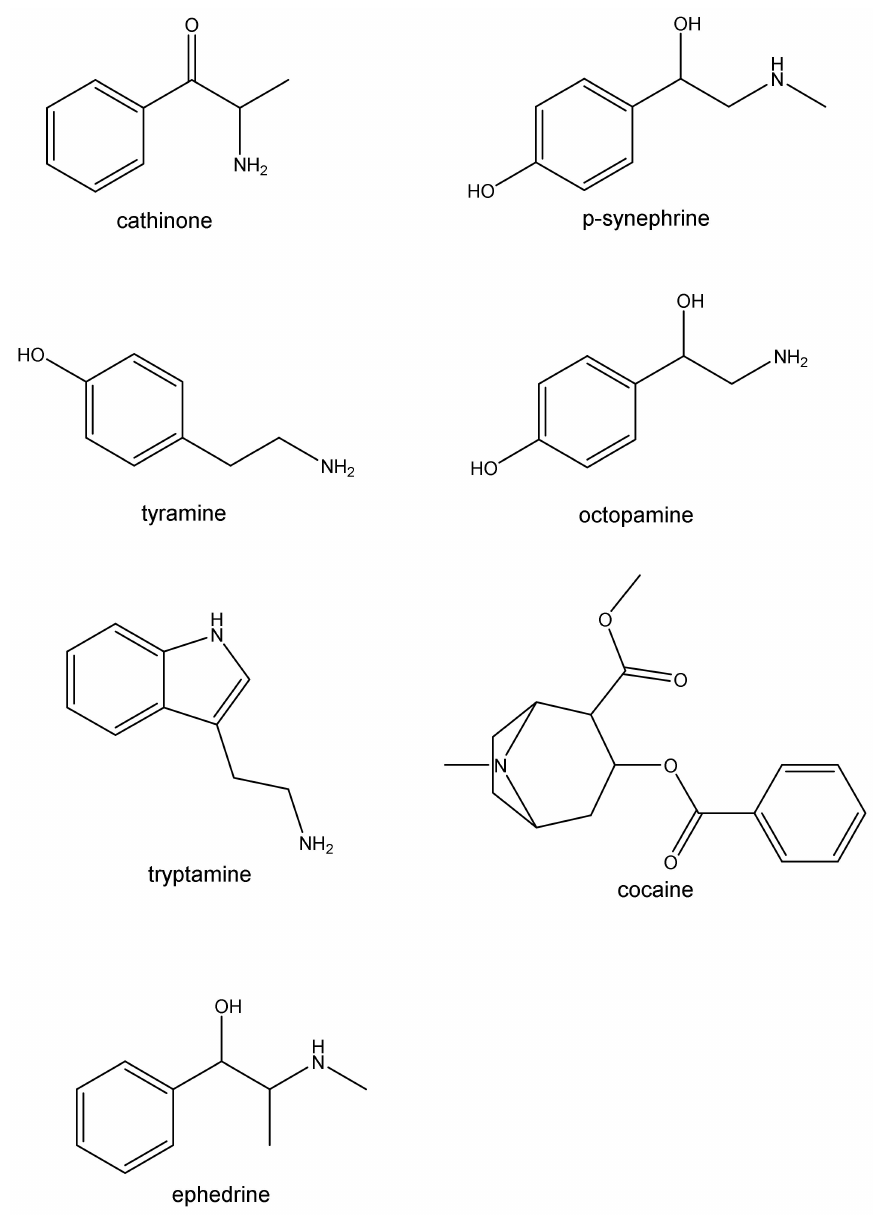
Figure 2. Chemical structures of several natural occurring